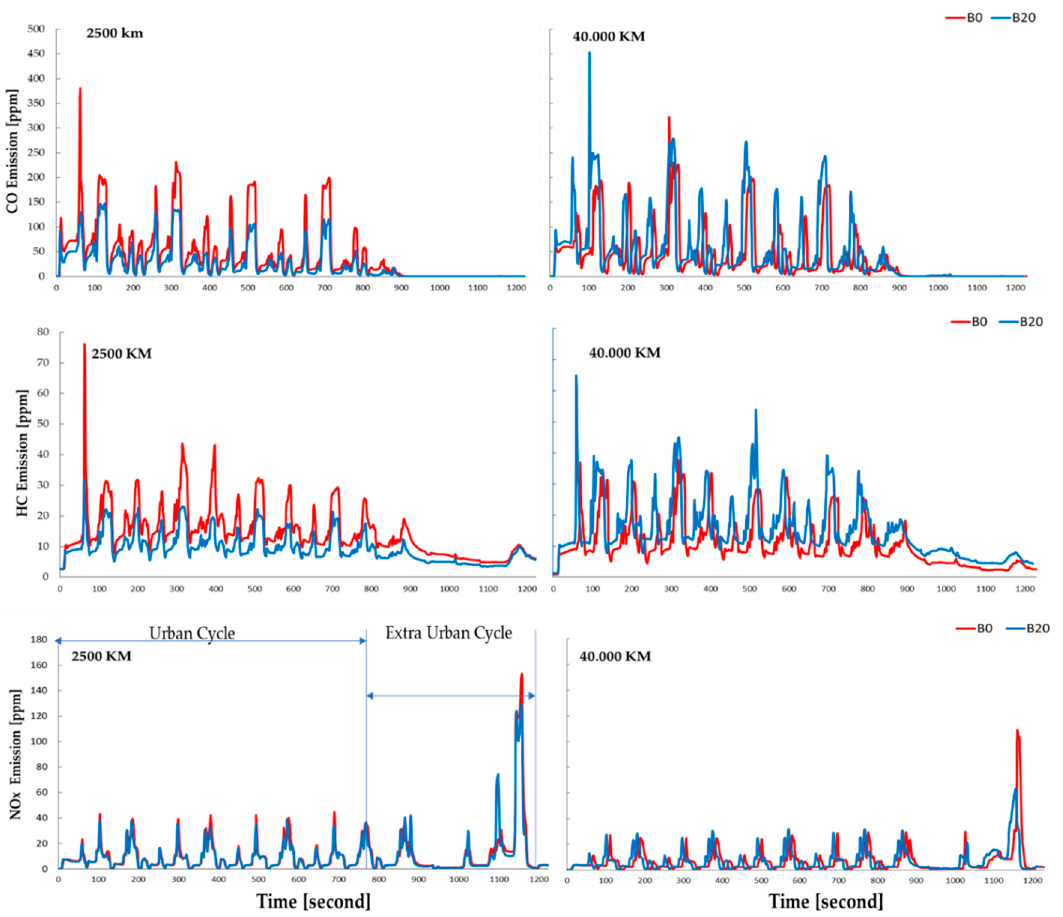
Figure 4. Transient CO, HC and NOx emissions for B0 and B20 at traveled distances of 2500 km and 40,000 km.